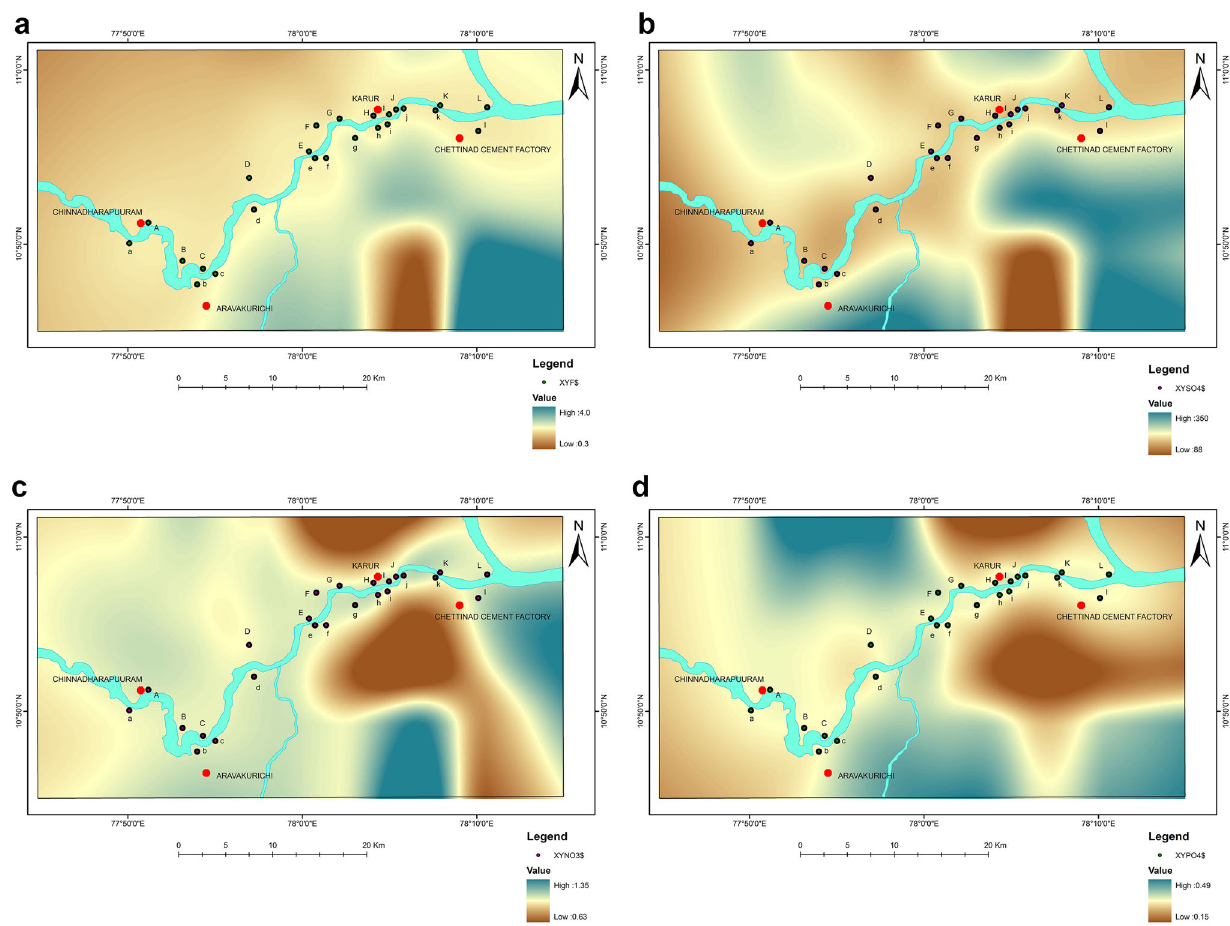
Fig. 5 a – d Spatial distribution of F, SO 4 , NO 3, and PO 4 in groundwater samples